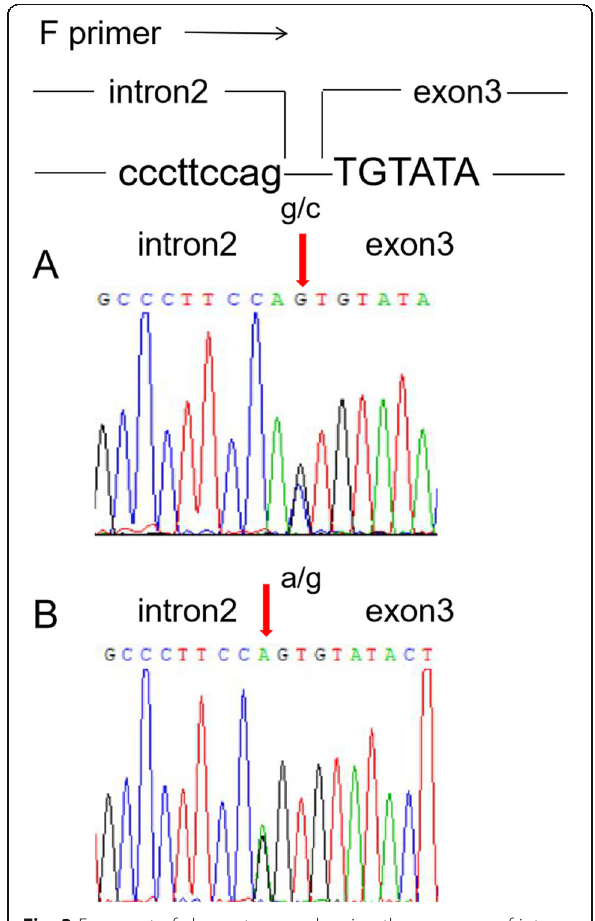
Fig. 3 Fragment of chromatogram showing the sequence of intron 2 and exon 3 of VHL gene in proband. Sequences amplified by